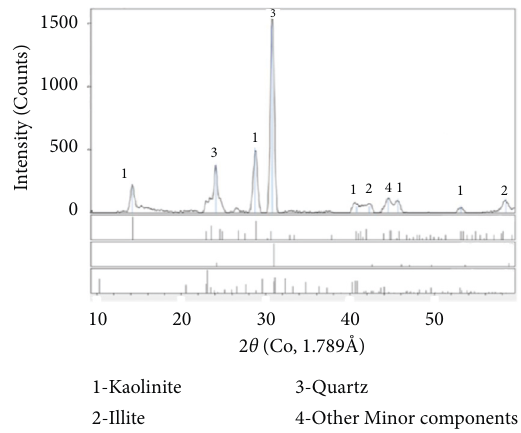
Figure 1: X-ray diffraction analysis of kaolin